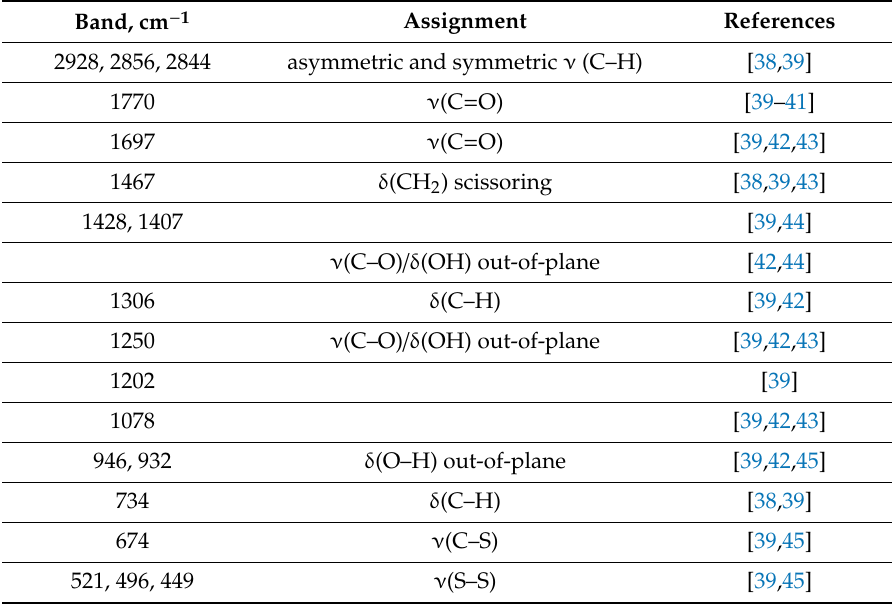
Table 2. Assignment of FTIR bands in the spectrum of crystal